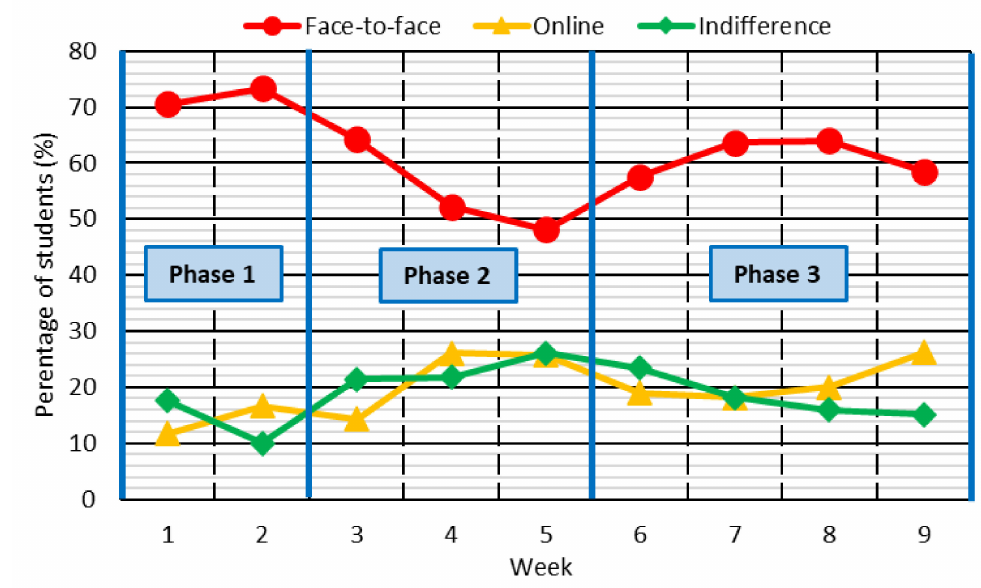
Figure 4. Preferred teaching